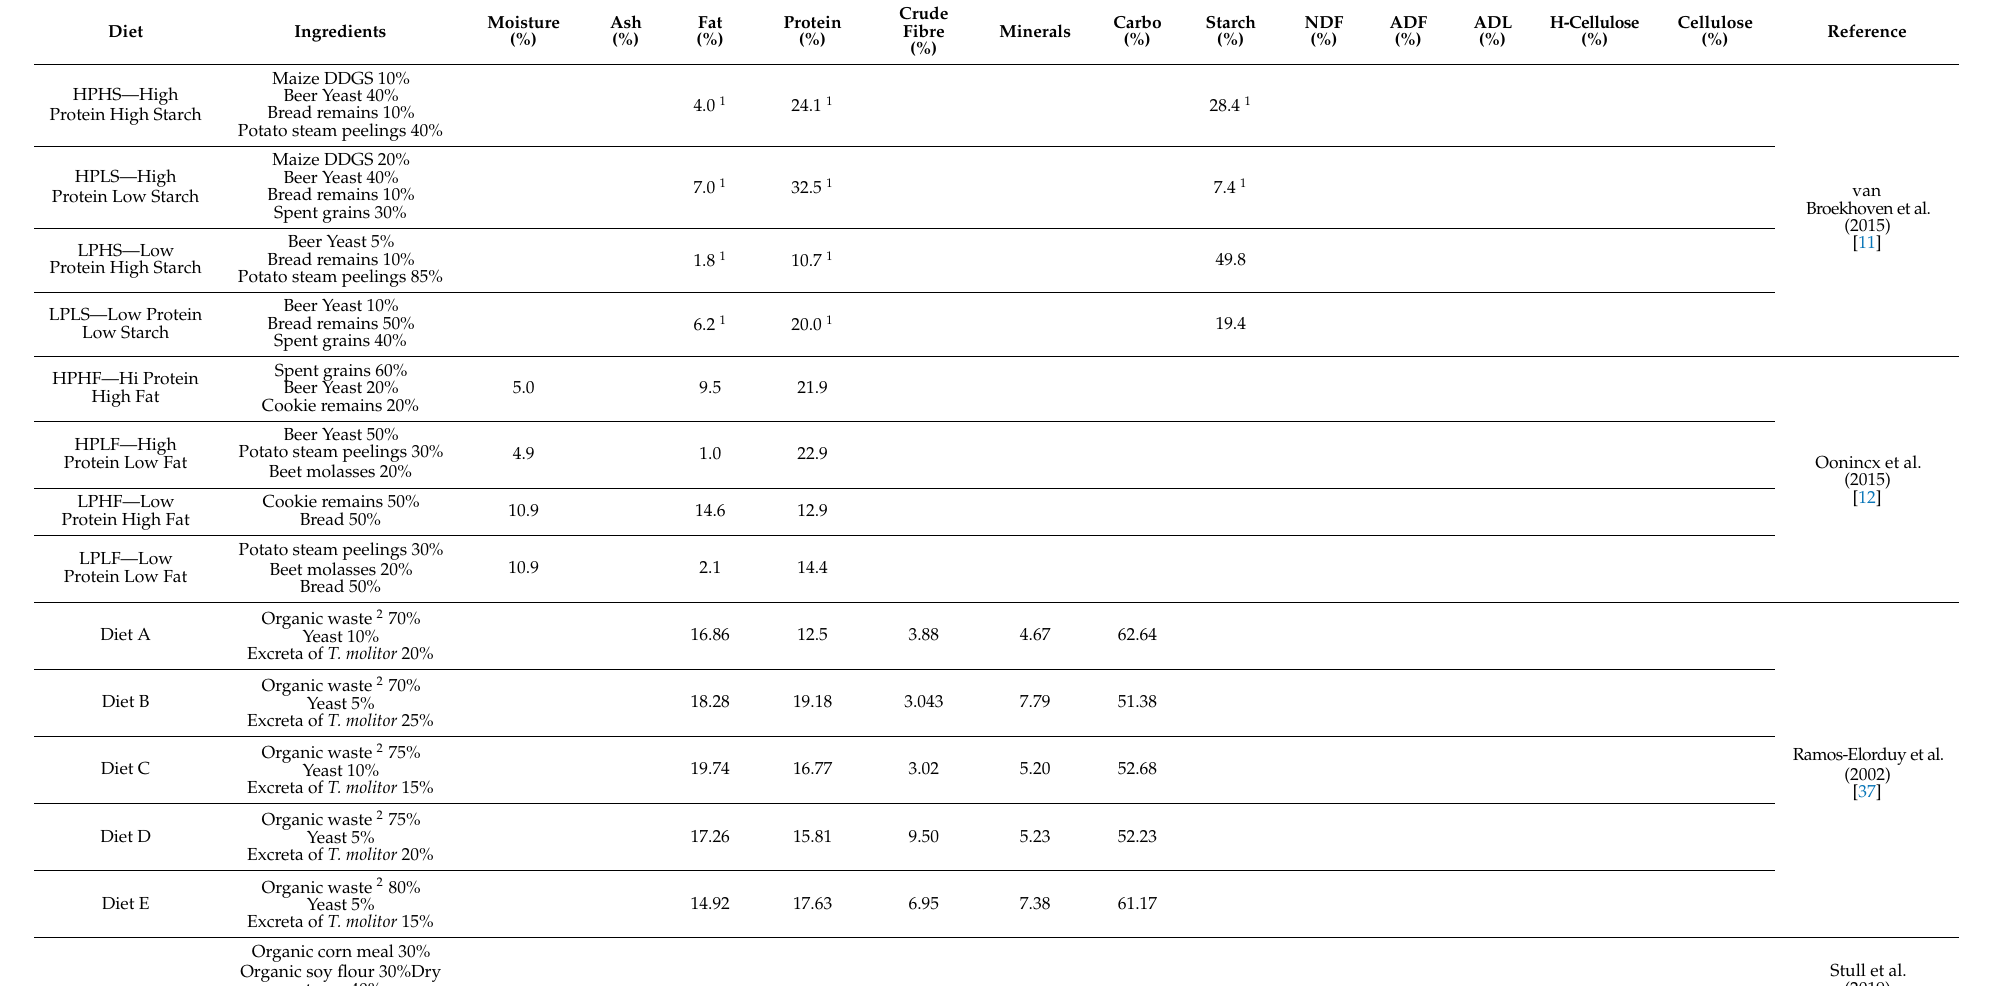
Table 1. Chemical composition (% DM) of discussed diets used for yellow mealworm